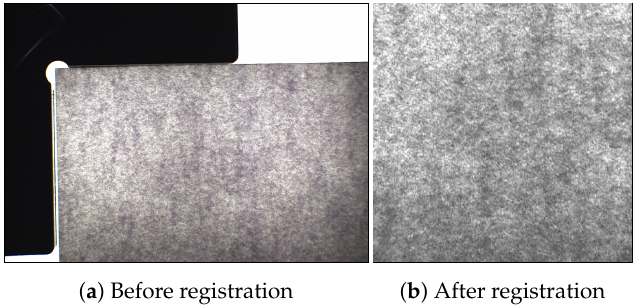
Figure 3. Document acquisition with VSC before registration ( a ) and after registration ( b ).